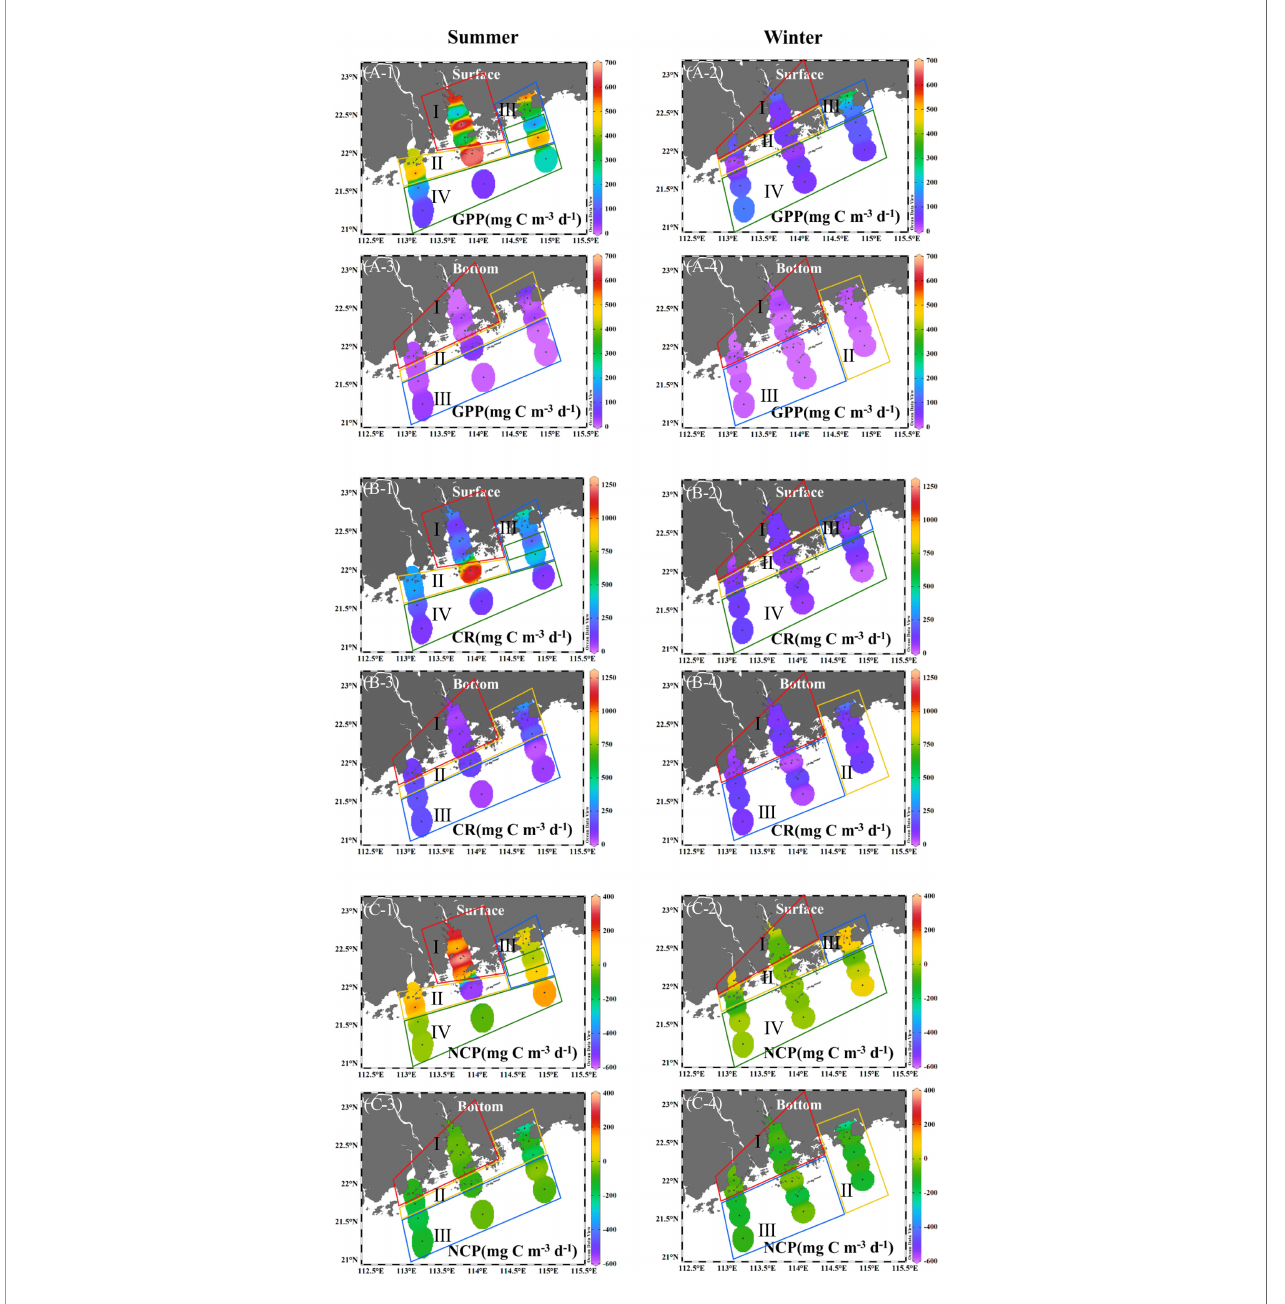
FIGURE 4 | Distribution characteristics of GPP ( A , mg C m -3 d -1 ), CR ( B , mg C m -3 d -1 ), and NCP ( C , mg C m -3 d -1 ) in surface and bottom seawater along transections (A-C) of the GGBA in summer and winter periods. The clusters divided here are consistent with the clusters shown in Figure 5